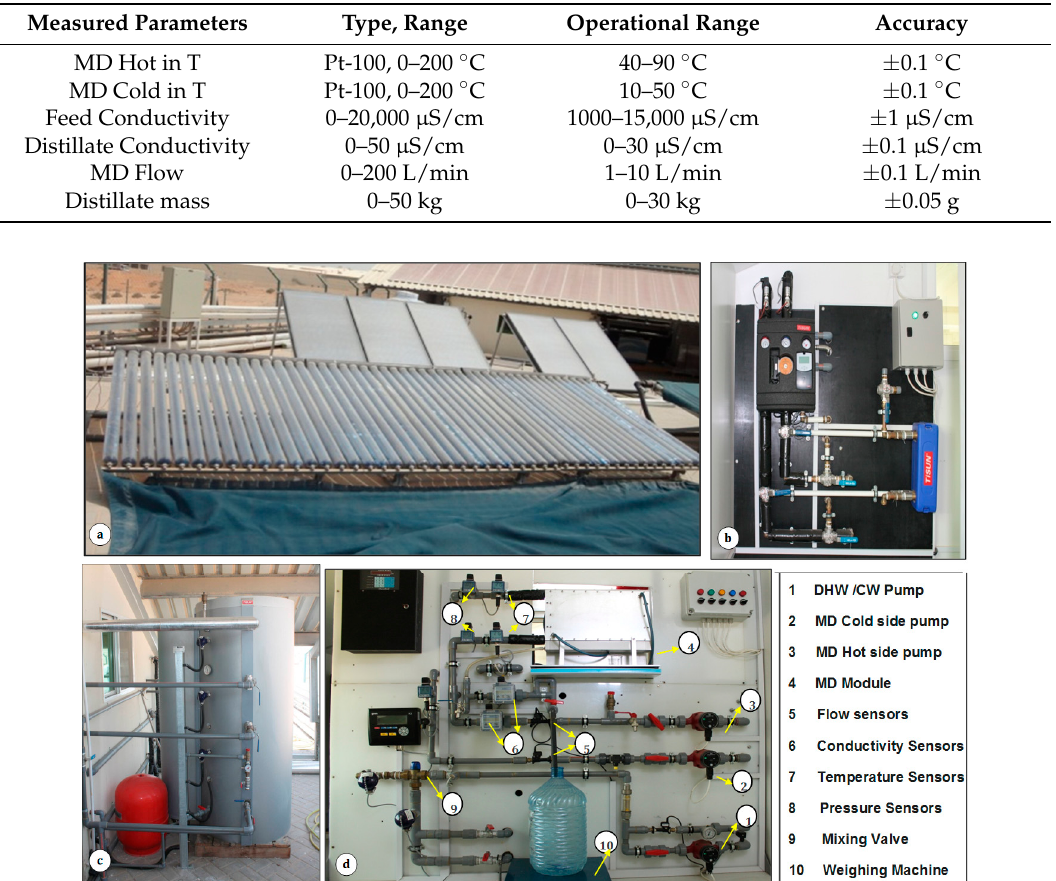
Table 1. Measured parameters, operational range and accuracy of instruments.